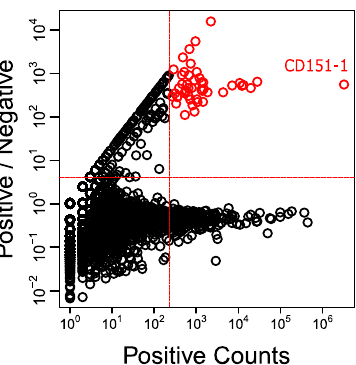
Fig. 3 NGS enrichment ranking selection of CD151 in situ selection of Ab clones. The abundance of each sequence (N:105,434) in Fab-phage pools selected for binding to HEK293T-CD151 + cells (positive counts, x-axis) is plotted versus the ratio of the abundance in pools selected for binding to HEK293T-CD151 + cells over pools selected for binding to HEK293T-CD151 − (positive/negative, y-axis). Each circle represents one unique paratope (i.e., unique combination of CDRs L3, H1, H2, and H3). The dashed red lines de fi ne an upper-right quadrant that contains putative CD151 binding clones, de fi ned arbitrarily as those occurring more than 200 times in the positive pool and being greater than fourfold enriched relative to the negative pool. The red circles represent the 100 Ab clones in the upper-right quadrant that were selected after the NGS analysis and predicted to bind to CD151. All selected clones are close homologs (>80% sequence identity) of the immunodominant Ab clone CD151-1. The red circle at the far right represents the immunodominant Ab clone CD151-1 that was manually sampled and validated as an anti-CD151 Ab by cellular phage ELISA (Fig.